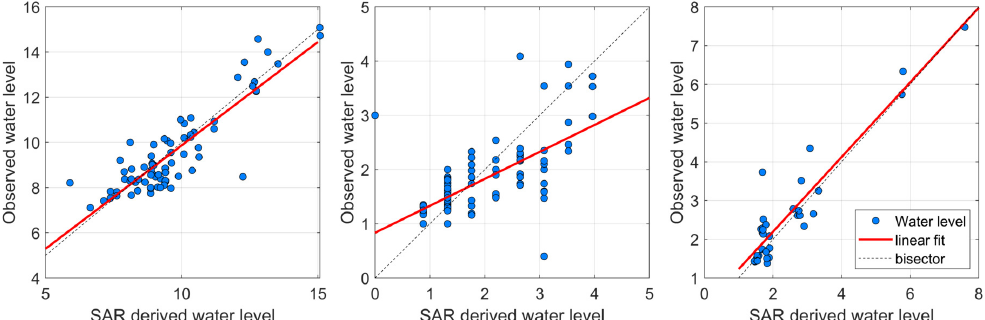
figure. A possible solution to improve the performance of the algorithm could be the installation of corner reflectors in the scene to mitigate the effect of the noise introduced in the radar measurements.